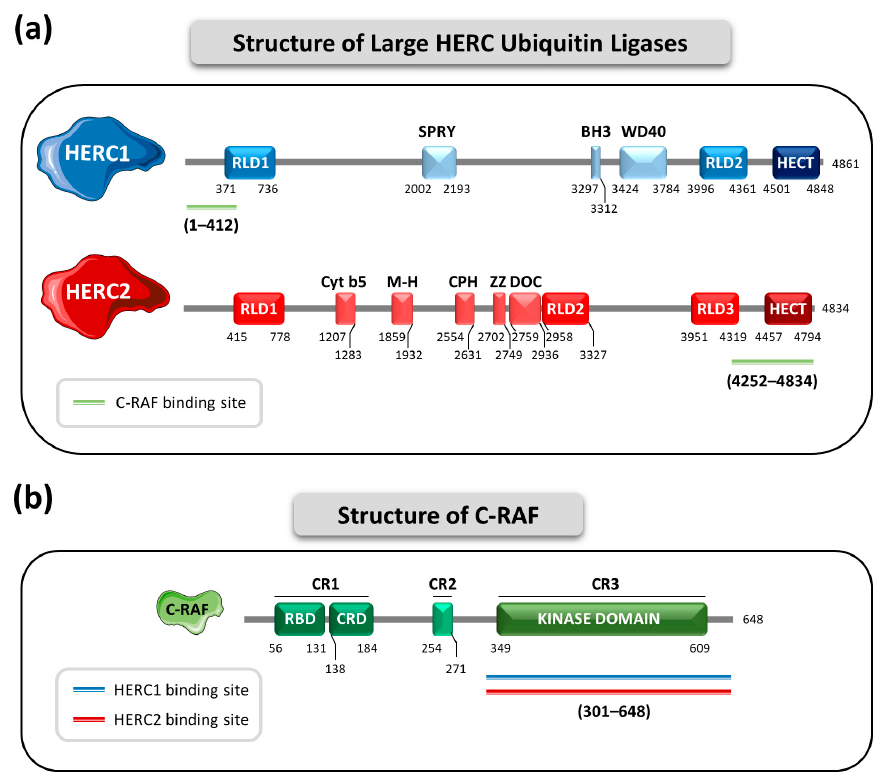
Figure 2. Structural characteristics of Large HERCs and C-RAF. ( a ) Domain architecture of HERC1 (depicted in blue) and HERC2 (depicted in red). Key domains and their boundaries are shown. C-RAF-interacting regions are indicated by a green line. ( b ) Domain architecture of C-RAF (depicted in green). Key domains and their boundaries are shown. The HERC1- and HERC2-interacting regions are indicated by a blue and red line, respectively.